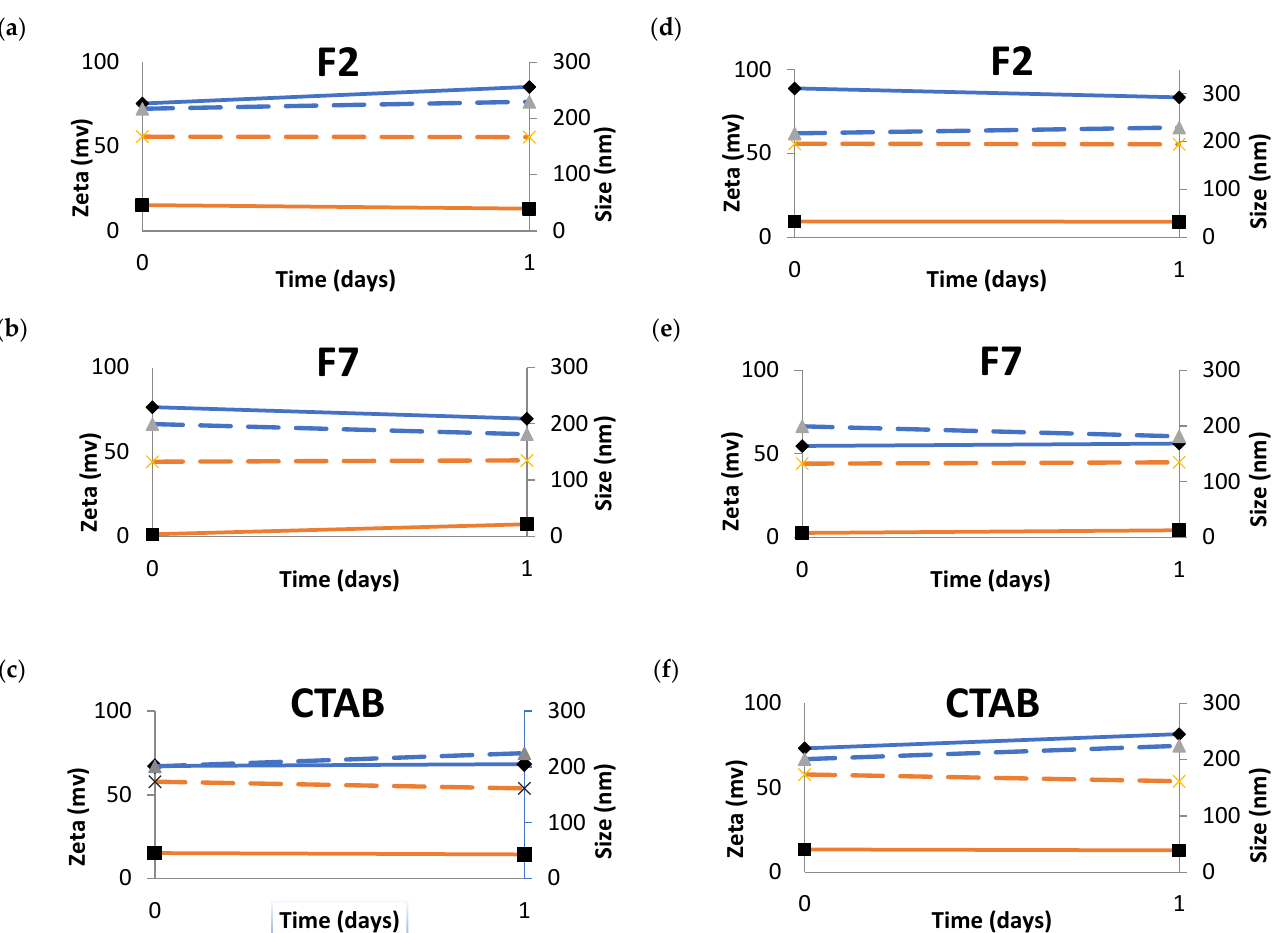
Figure 12. Behavior of NEs in sterile phosphate buffer at neutral pH for two different dilutions, at 1:1 (left-hand side panels, ( a – c )) and at 1:3 (right-hand side panels, ( d – f )). Blue line refers to: mean particle size of NE after dilution in the different solutions (continuous line) and mean particle size of original NEs (dashed line); orange line refers to: ZP of NEs after dilution in the different solutions (continuous line) and ZP of original NEs (dashed line).